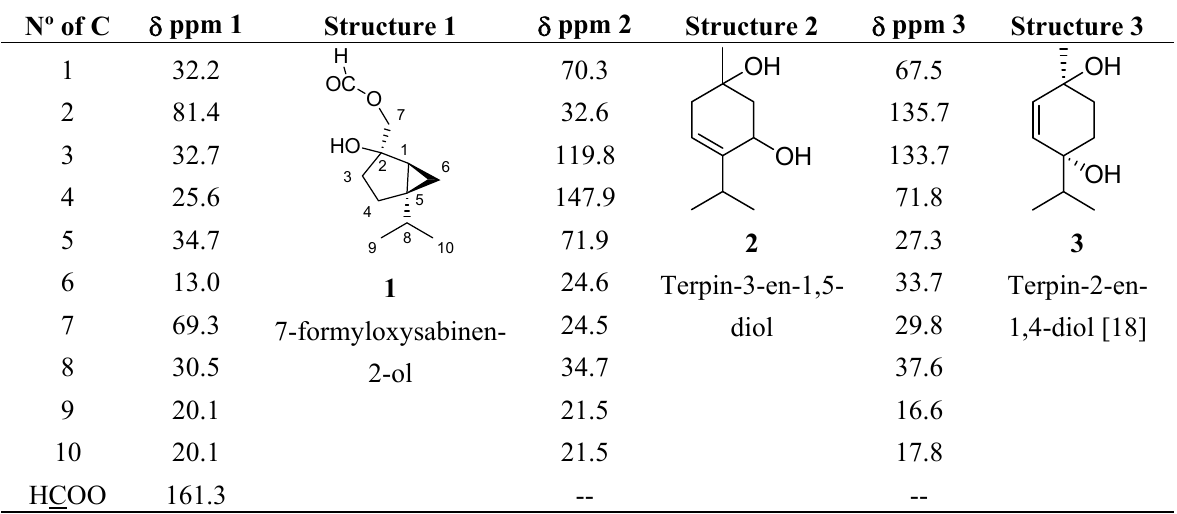
Table 4. Attribution of the 13 C-NMR data of compounds 1 – 3